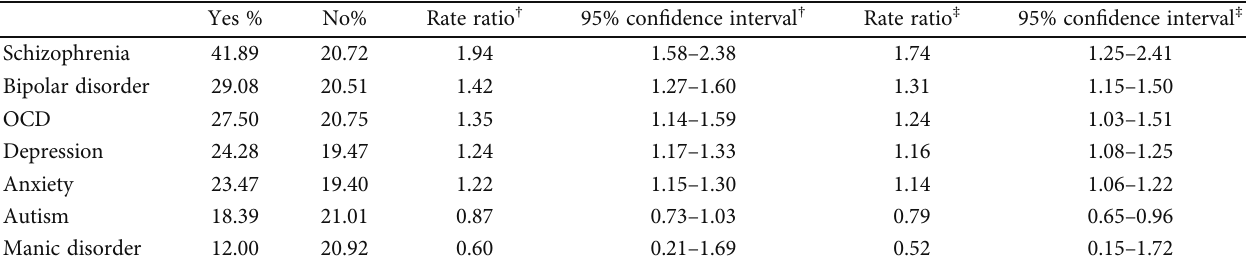
Table 4: Rate of injury among ADHD cases according to whether other comorbid mental health conditions exist.